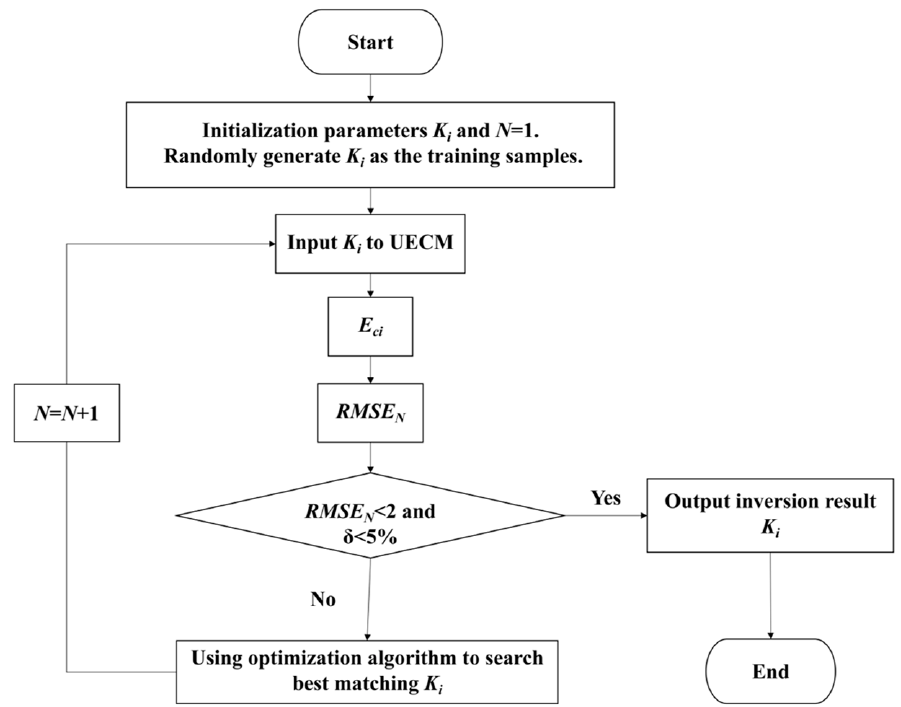
Figure 1. Flowchart for the inversion of the Hami concrete-face rockfill dam foundation’s hydraulic conductivity.